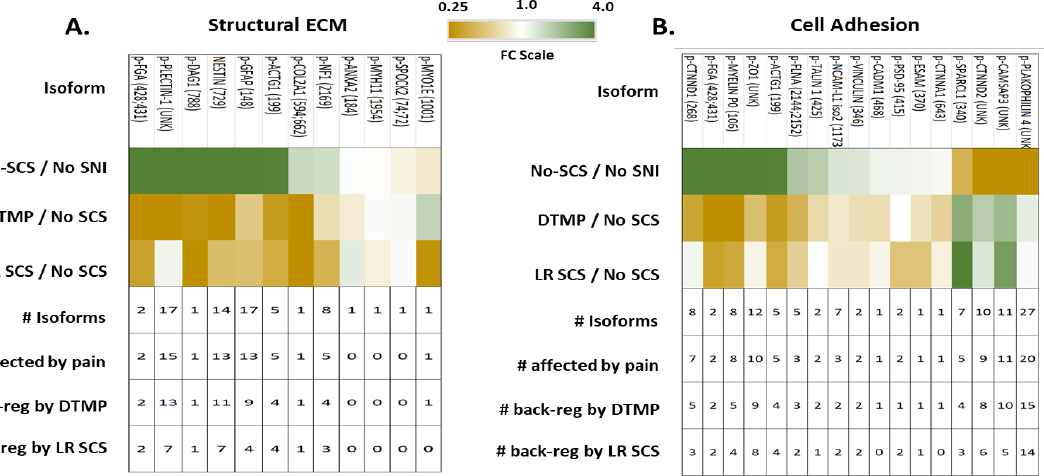
Figure 4. Heat maps with expression level fold changes (FC) of selected phosphoproteins isoforms associated with ( A ) structure of the ECM, ( B ) cell adhesion at the ECM. Only the isoforms with the largest expression change due to the pain model are shown for each phosphoprotein. Values in the table below the heat map indicate the number of isoforms identified, how many were affected by the pain model and how many of these were back-regulated (back-reg) by DTMP or LR SCS. Out of the 93 ECM proteins identified to be phosphorylated, 17 are cell adhesion pro-